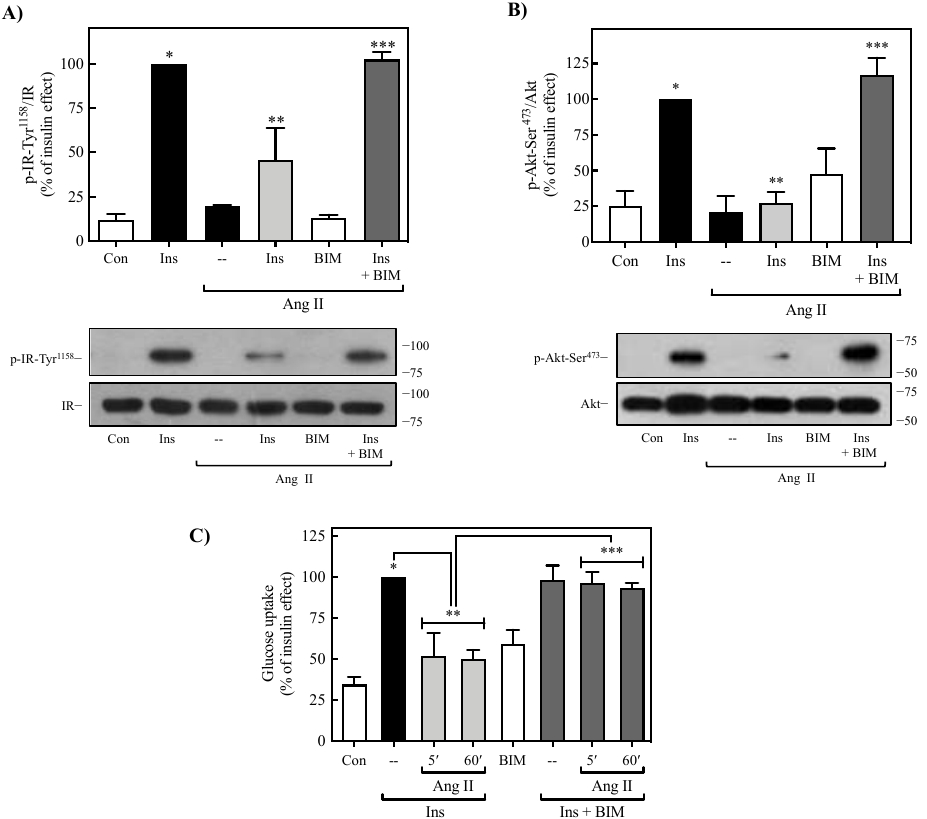
Figure 4. Role of PKC in Ang II-mediated regulation of insulin signaling. 3T3-L1 adipocytes were treated with or without 1 μM BIM for 30 min, then stimulated with or without 100 nM Ang II for 60 min. Finally, the cells were stimulated with or without insulin for 90 min. Total cell lysates were separated by SD-PAGE and analyzed by immunoblotting with anti-p-IR Tyr 1158 ( A ) or anti-p-Akt Ser 473 antibodies ( B ). Blots were quantitated by densitometry, and the mean values were plotted from three – five independent experiments. Western blots were also probed for total IR ( A ) and Akt ( B ) and used for data normalization. ( C ) Cells were treated with or without 1 μM BIM for 30 min, then stimulated with or without 100 nM Ang II for 5 or 60 min, and finally stimulated with or without insulin for 90 min. Glucose uptake was evaluated, as described in the Methods. Under all experimental conditions, cells without treatment were considered as controls. The values are reported as a percentage of insulin effect ± S.E.M. of at least three experiments. ( A , B ) * p < 0.05 vs. Con; ** p < 0.05 vs. Ins; *** p < 0.05 vs. Ins + Ang II. ( C ) * p < 0.05 vs. Con; ** p < 0.05 vs. Ins (--); *** p < 0.05 vs. Ang II + Ins (5′, 60′). BIM, BIM I; Con, control; Ins, insulin.